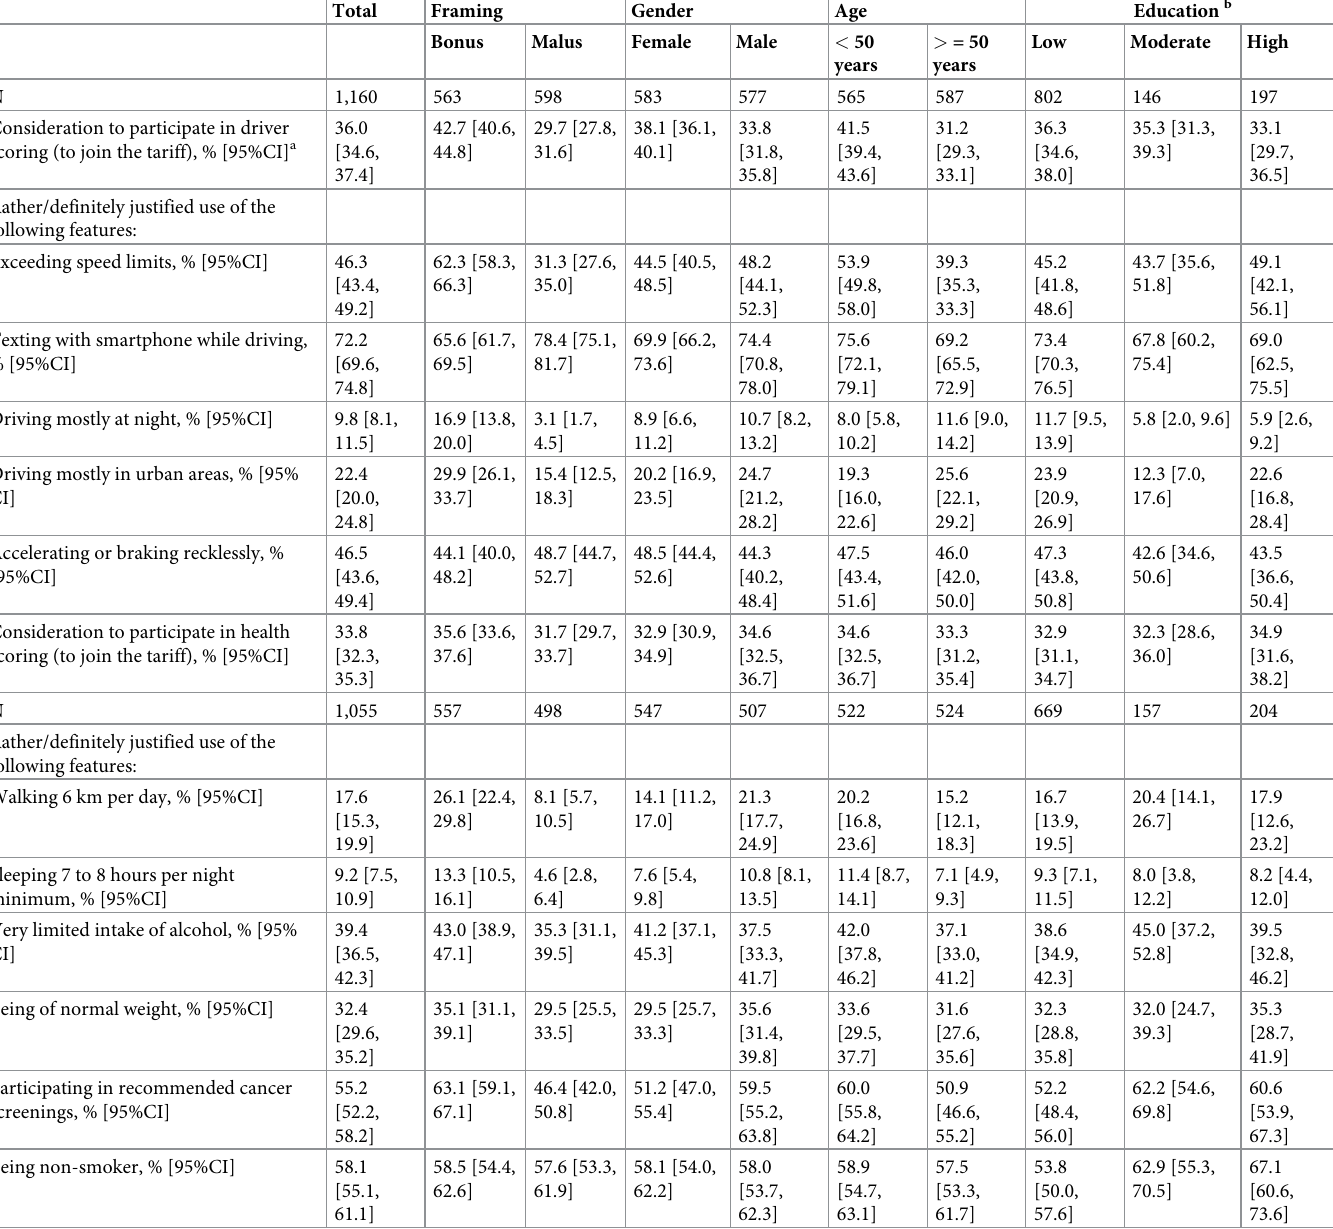
Table 2. Percentage of participants who considered participation in driver or health scoring programmes and their ratings of the features as “rather” or “definitely” justified. Total Framing Gender Age Education b Bonus Malus Female Male < 50